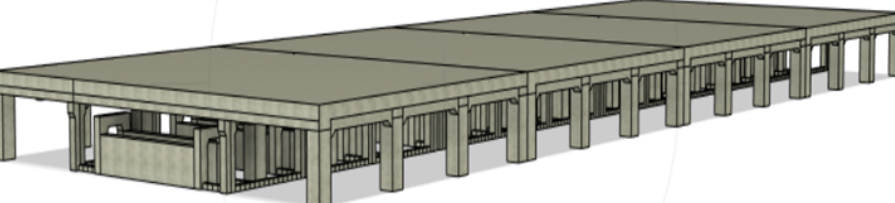
Figure 12. Model of the basement of the